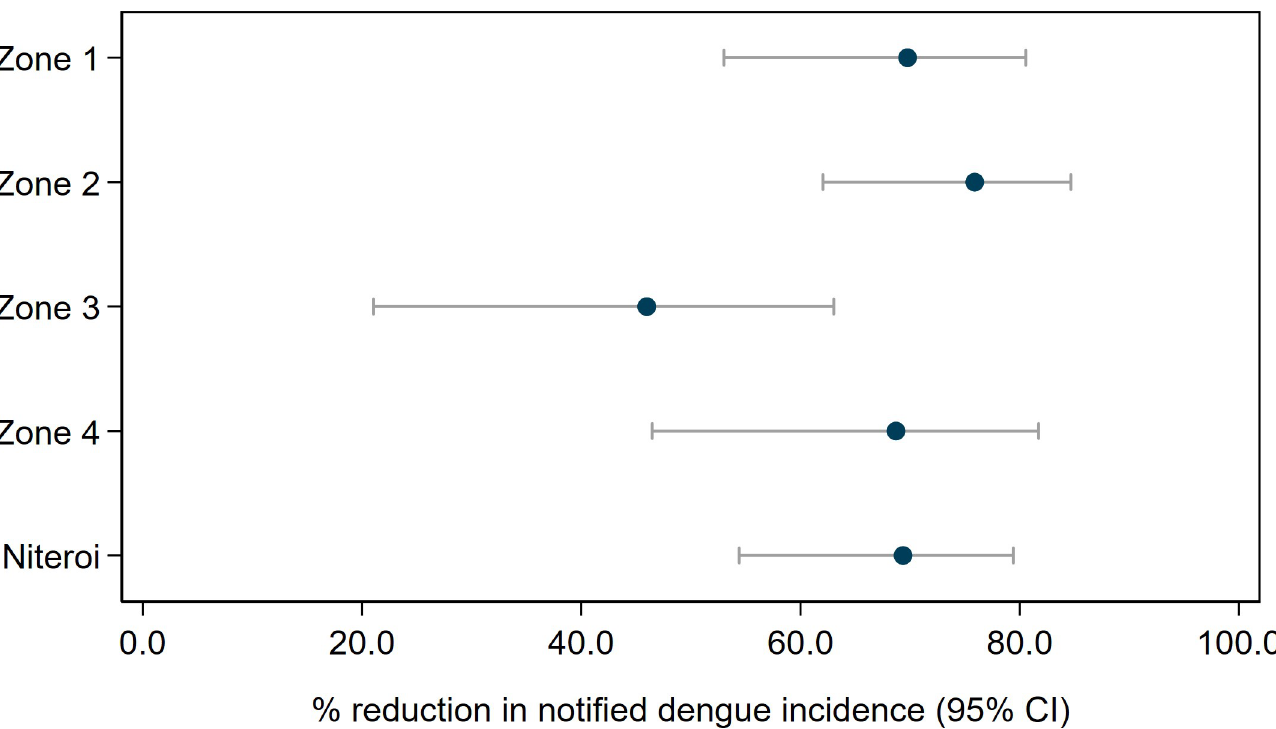
Fig 7. Estimated reduction in the incidence of dengue following Wolbachia deployments in Nitero´i, in each release zone individually and in the aggregate release area. Point estimates (circles) and 95% confidence intervals (horizontal bars) from controlled interrupted time series analysis of monthly dengue case notifications to the Brazilian national disease surveillance system (Jan 2007 –June